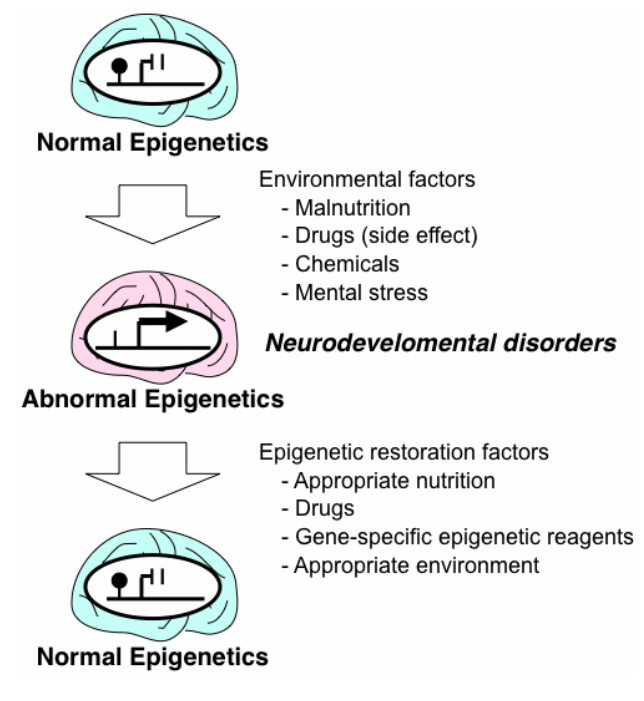
Figure 3. Overview of epigenetic change and environmental factors in the